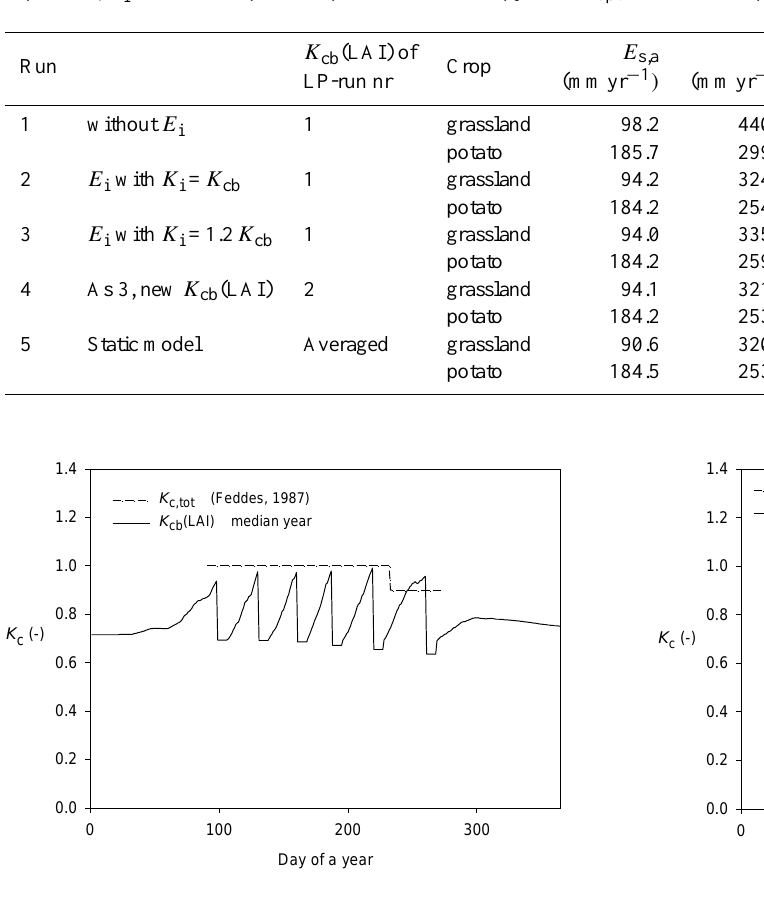
Table B2. Evapotranspiration terms of the simulation runs used for K cb (LAI) parameterization. The meteorological data of De Bilt (NL) for the period 1971–2000 are used, consisting of hourly precipitation data with a mean yearly total of 794mmyr − 1 . The mean reference crop evapotranspiration (Makkink) is 543mmyr − 1 . Where E s,a is the actual soil evaporation plus ponding evaporation, T p is the potential transpiration, E i is the interception evaporation from canopy and ET opt is the total evapotranspiration of an unstressed crop.